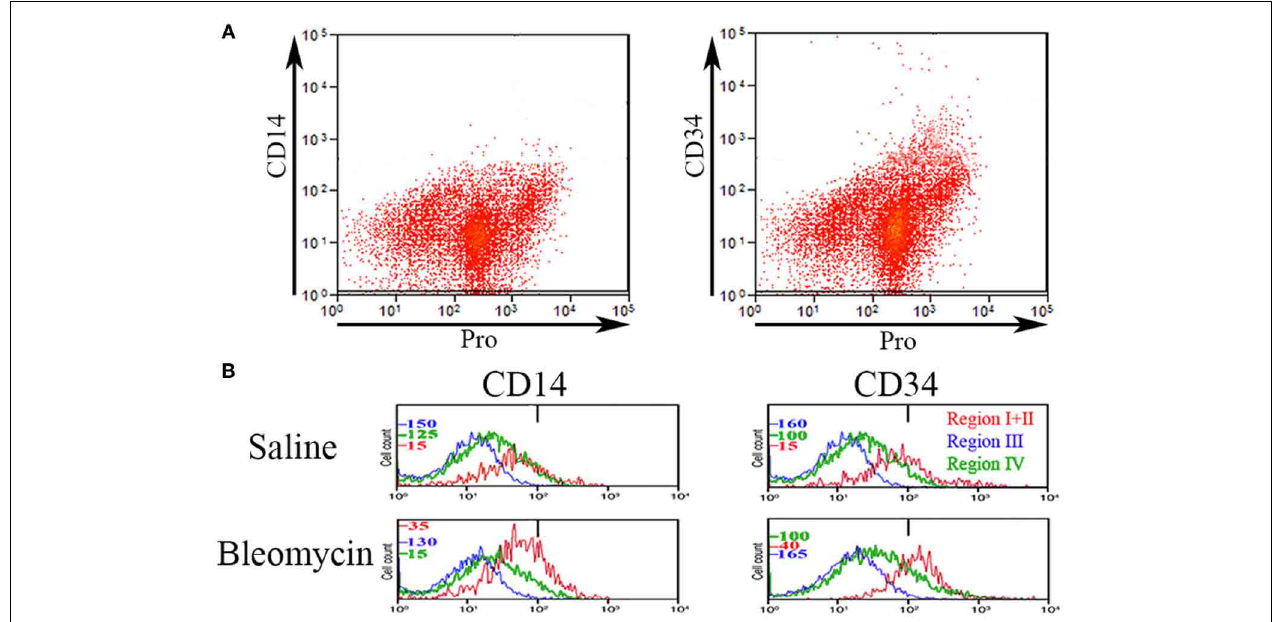
FIGURE 4 | CD14 and CD34 in Regions I–IV. (A) Total lung cells from a bleomycin-treated mouse sacrificed 28 days after initiation of treatment were immunolabeled for Pro and either CD14 or CD34. Scatter plots of fluorescence intensity are presented with CD14 or CD34 on the y-axis and Pro on the x-axis. Note that unlike CD45 (see Figure 1 ), neither CD14 nor CD34 had a clearcut bimodal distribution of fluorescence intensity. (B) Total lung cells from a saline- and a bleomycin-treated mouse sacrificed 28 days after initiation of